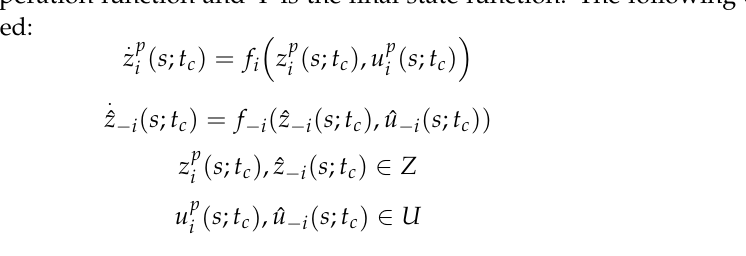
Figure 4. Classification of MPC: ( a ) Centralized MPC; ( b ) Decentralized MPC; ( c ) Distributed MPC.